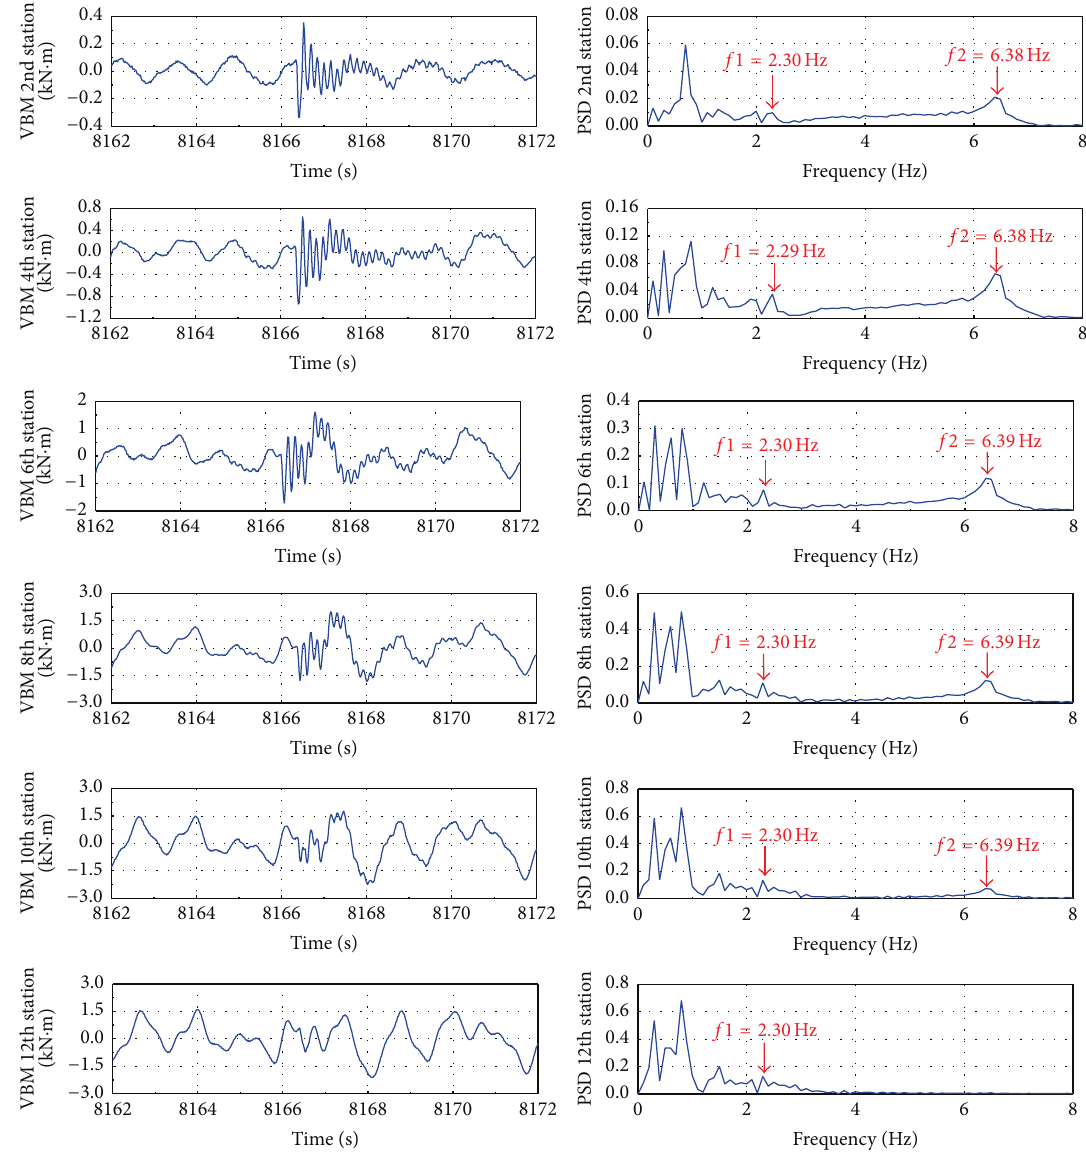
Figure 18: Time and frequency series of VBM at different